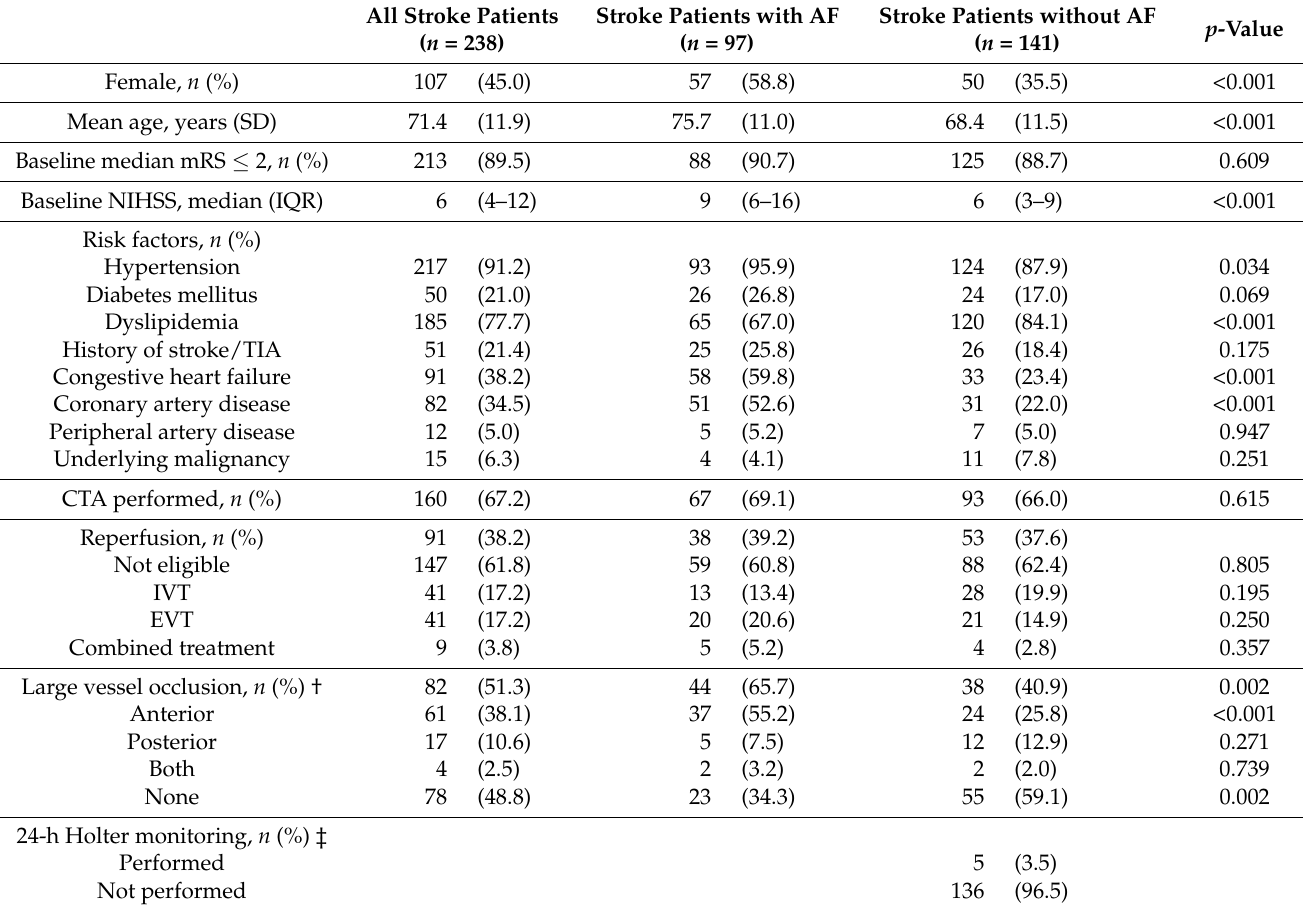
Table 1. Demographic and clinical characteristics for stroke patients with and without atrial fibrilla- tion. Significant p -values are shown in bold. All Stroke